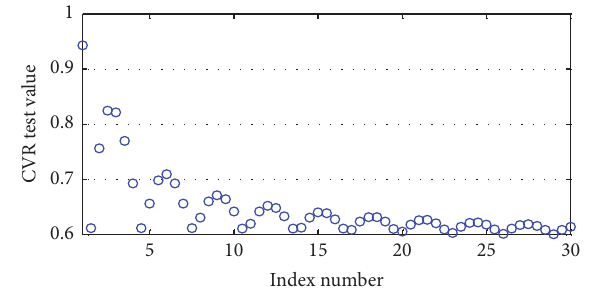
Figure 13: CVR test value.